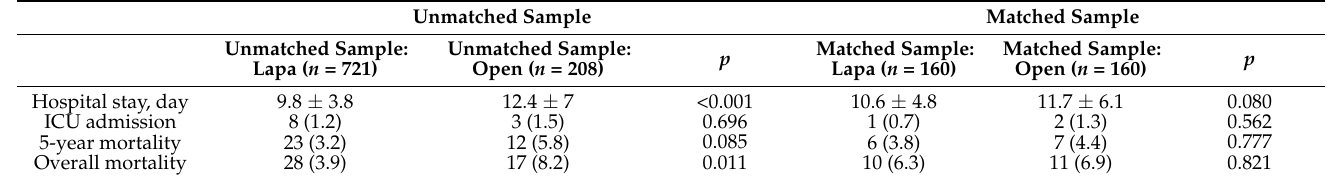
Table 3. Surgical outcomes in the unmatched and matched